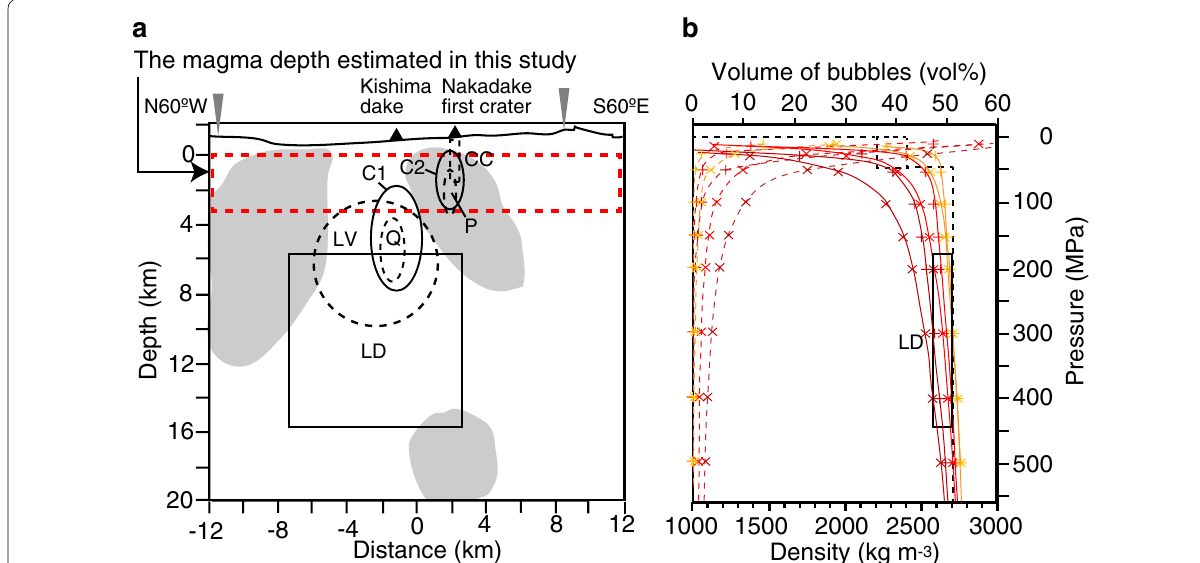
Fig. 7 A cross section of Aso caldera and results of a density calculation of magma. a Comparison of the magma depth estimated in this study with geophysical observations. This cross section is along the profile in Fig. 1 (profile A2 in Hata et al. 2016). The magma chambers and conduits proposed by geophysical observations are also shown. LD is a low-density cylindrical block with a density contrast of 150 kg m − 3 , which is lower than that of the surrounding rocks, and is located at 6–17 km depth (bsl) with a radius of 5 km (Komazawa 1995). LV is a low-velocity region that is roughly spherical in shape, has a radius of about 3 km, is centered at 6 km depth, and extends to 10 km depth (Sudo and Kong 2001). P and Q are hot regions, that is, reflector voids revealed by a 3-D seismic reflection analysis (Tsutsui and Sudo 2004). CC is a crack-like conduit with a dimension of 1 km at a depth of about 1.8 km (bsl) beneath the Nakadake first crater based on the spatial pattern of the observed long-period tremors amplitudes (Yamamoto et al. 1999). C1 and C2 are a magma chamber and a conduit, respectively, inferred from significant conductive block anomalies indicated by the three-dimensional modeling of the electrical resistivity structure (Hata et al. 2016). A portion with less than 10 O-m of the anomaly C1, whose most conductive cell at 4 km depth (bsl) indicated a melt fraction of 76–87%, was distributed from 8 to 2 km depth (bsl). The horizontal of the anomaly C1 is beneath Kishimadake, which is consistent with the estimate of Sudo and Kong (2001). The anomaly C2 is centered at 2 km depth (bsl) and ranges from 4 to 0 km. Gray areas indicate JMA earthquake hypocenters within 2 km of the profile line between June 2002 and April 2016 (Hata et al. 2016). These geophysical observations indicate the presence of a magma chamber at 2–10 km depth (bsl). b Density (solid curves) and volume of bubbles (broken curves) of the A1, A2, A3, B1, B2, and B3 magmas calculated in this study (Table 5; Additional file 3: Table S2). The symbols are the same as in Fig. 5. Black broken lines indicate the density structure beneath the Aso caldera investigated by Komazawa (1995). He estimated the density structure to be 2200–2400 kg m − 3 at a depth less than 1 km (bsl) and 2700 kg m − 3 at a depth greater than 1 km. LD is a low-density block with a density contrast of 150 kg m − 3 extended from 6 to 17 km depth (bsl) proposed by Komazawa (1995). Comparison between the bulk densities of the A1, B1, A3, and B3 magmas and the density of the crust at different depths indicated. (1) At 200–600 MPa (6–21 km depth (bsl)), the A1, B1, A3, and B3 magmas had lower or similar bulk density (2586–2787 kg m − 3 ) than the crust (Additional file 3: Table S2). The density contrast between the A1 and B1 magmas and crust at 200 MPa was 68–114 kg m − 3 , which was similar to the indication from the gravimetric analysis. (2) At pressures of 50–200 MPa (1–6 km depth (bsl)), the magmas had lower bulk densities than the crust (2345– 2632 kg m − 3 for A1 and B1 magmas and 2562–2692 kg m − 3 for A3 and B3 magmas; Table 5; Additional file 3: Table S2), which would allow the magmas to ascend by buoyancy. (3) At a pressure of 25 MPa (0 km depth (bsl), the B1 magma had lower bulk density than the crust (2007 kg m − 3 for B1 magma versus 2200–2400 kg m − 3 for the crust), while the A1, A3, and B3 magmas had higher or similar bulk density (2400–2594 kg m − 3 ) to the